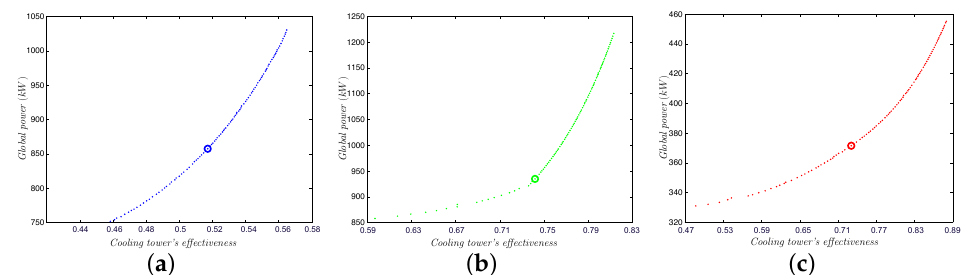
Figure 3. Pareto fronts and selected optimal solutions for 3 of the 35 operating points used in the implementation of the optimization with SPEA2 with stopping criterion after 50 iterations. ( a ) Operational point 8; ( b ) Operational point 16; ( c ) Operational point 26.